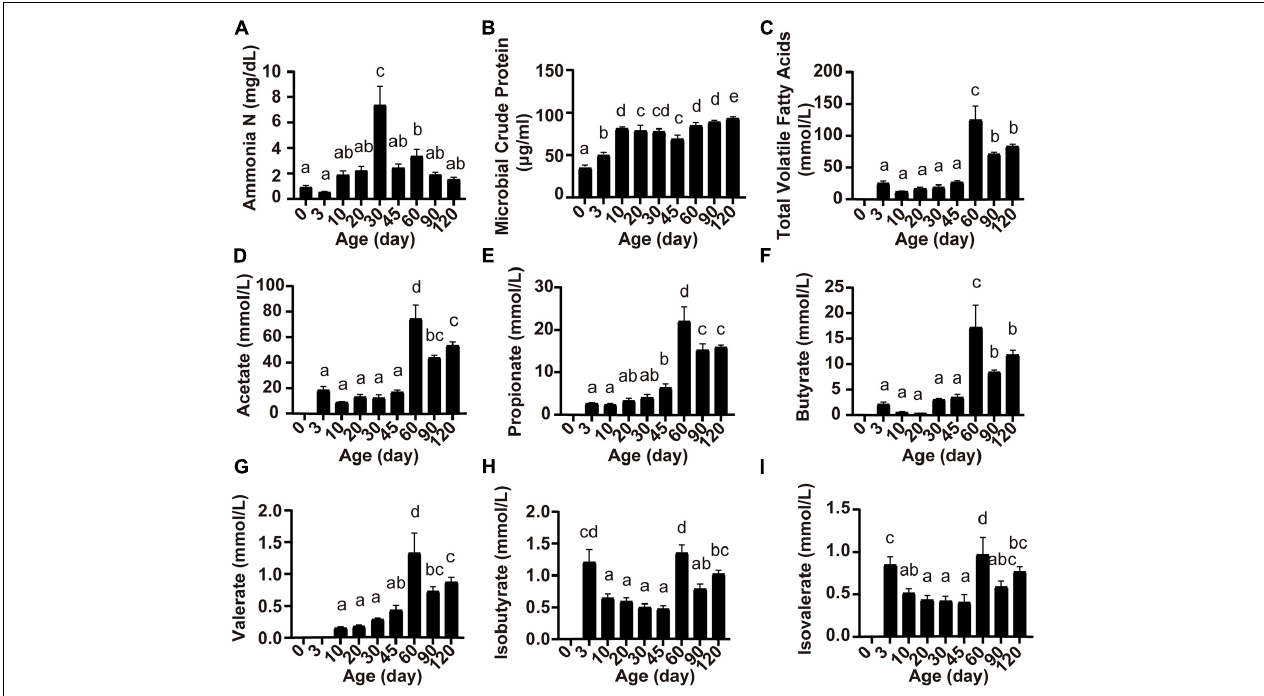
FIGURE 2 | Serum concentrations of ammonia N (A) , microbial crude protein (B) , total volatile fatty acids (C) , acetate (D) , propionate (E) , butyrate (F) , valerate (G) , isobutyrate (H) , and isovalerate (I) at different lamb ages. Data are expressed as mean ± SEM. a , b Letters denote significant differences between groups; groups that do not share the same letter are significantly different from each other ( P <